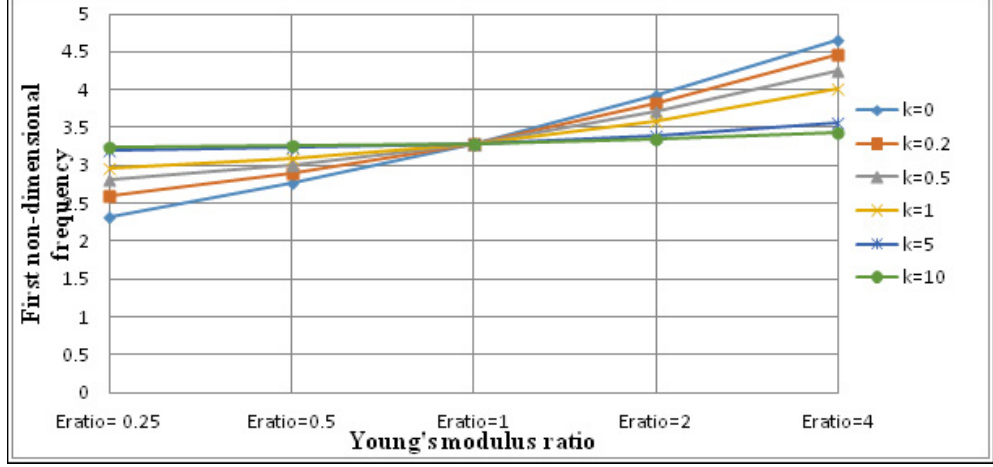
Figure 6: variation of the first non- dimensional frequency with Power Exponent (k)